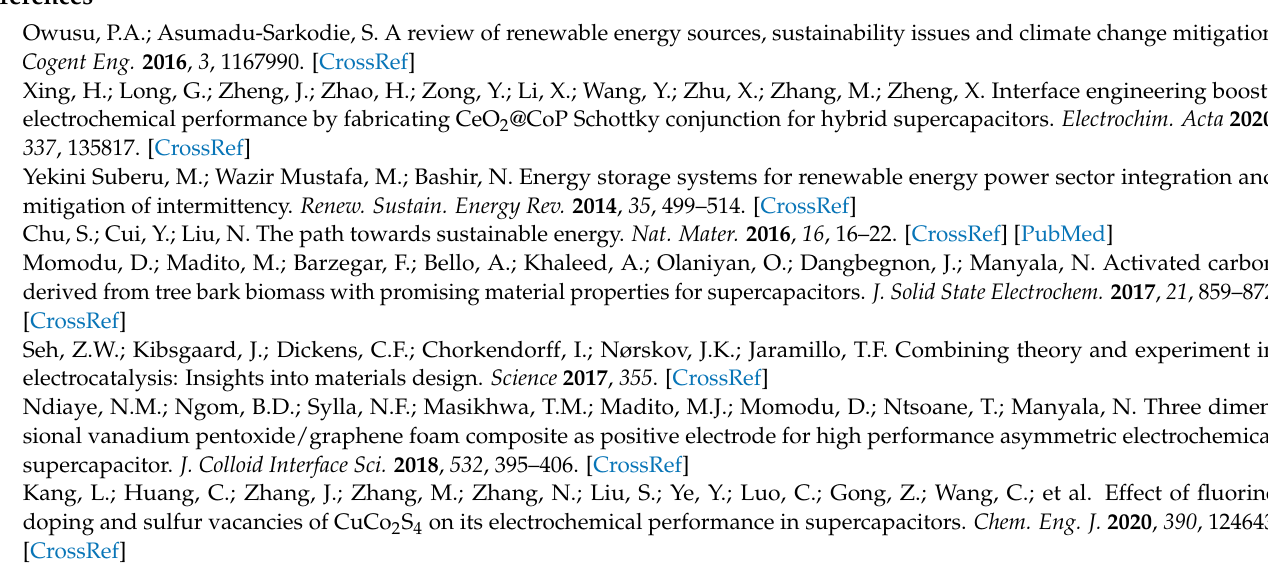
posites, Figure S1: High resolution XPS spectra C 1S and O 1 S of (a,d) PAC/MoO 2 /Mo 2 C-0.5 (b,e) PAC/MoO 2 /Mo 2 C-1 (c,f) PAC/MoO 2 /Mo 2 C-2 ternary composites, Figure S2: Galvanostatic charge-discharge curves at 1 A g − 1 (a) in − 0.9–0.0 V negative and (b) 0.0–0.9 V positive potential windows of the PAC/MoO 2 /Mo 2 C ternary composites in three-electrode configuration, Figure S3: (a,b) CV plots at different scan rate from 10 to 100 mV s − 1 in ( − 0.9–0.0 V) and (0.0–0.9 V) operating potential, (c,d) GCD curves at different specific currents ranging from 1 to 10 A g − 1 in ( − 0.9–0.0 V) and (0.0–0.9 V) operating potential of the PAC/MoO 2 /Mo 2 C-1 ternary composite in three-electrode configuration, Table S2: Comparison of electrochemical performance of Mo-based composite with carbon material in aqueous